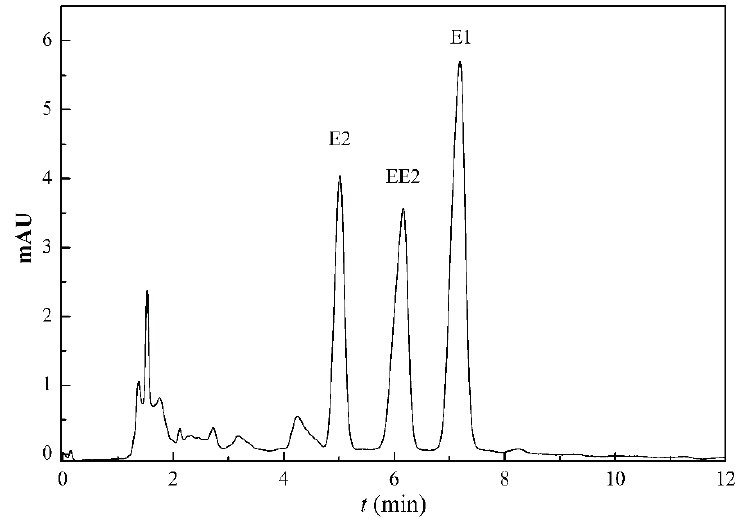
Figure 1. Liquid chromatography of three kinds of steroid